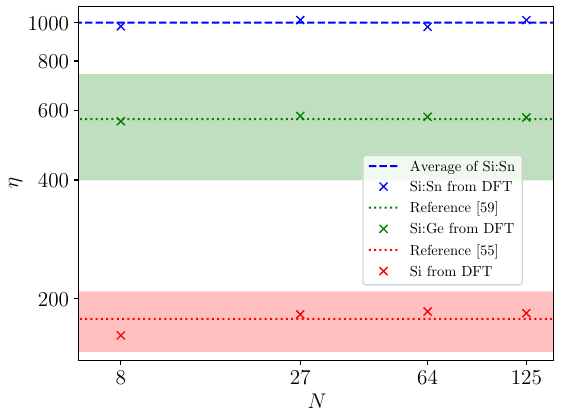
FIG. 2. The Fermi-contact densities obtained by DFT calcu- lations using the PBE functional, as performed on various n × n × n -dimensional supercells with atom count n 3 = N . Included for reference are the measured values η Si = 178 ± 31 and η Ge = 570 ± 171, corresponding to a 29 Si nucleus in the bulk [55] and a substitutional 73 Ge defect in silicon [59], respectively. The shaded bands represent the experimental